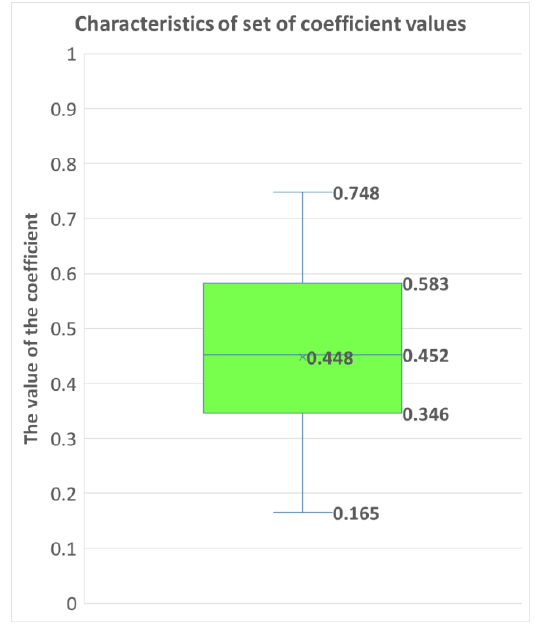
Figure 3. Characteristics of set of coefficient values.